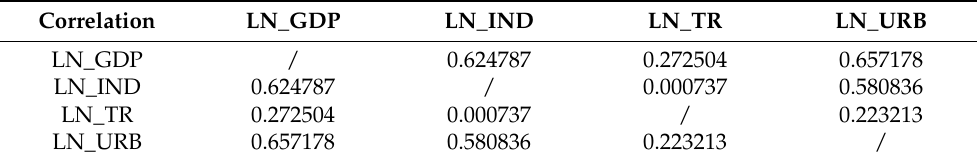
Table 3. Multi-collinear correlation coefficient of panel